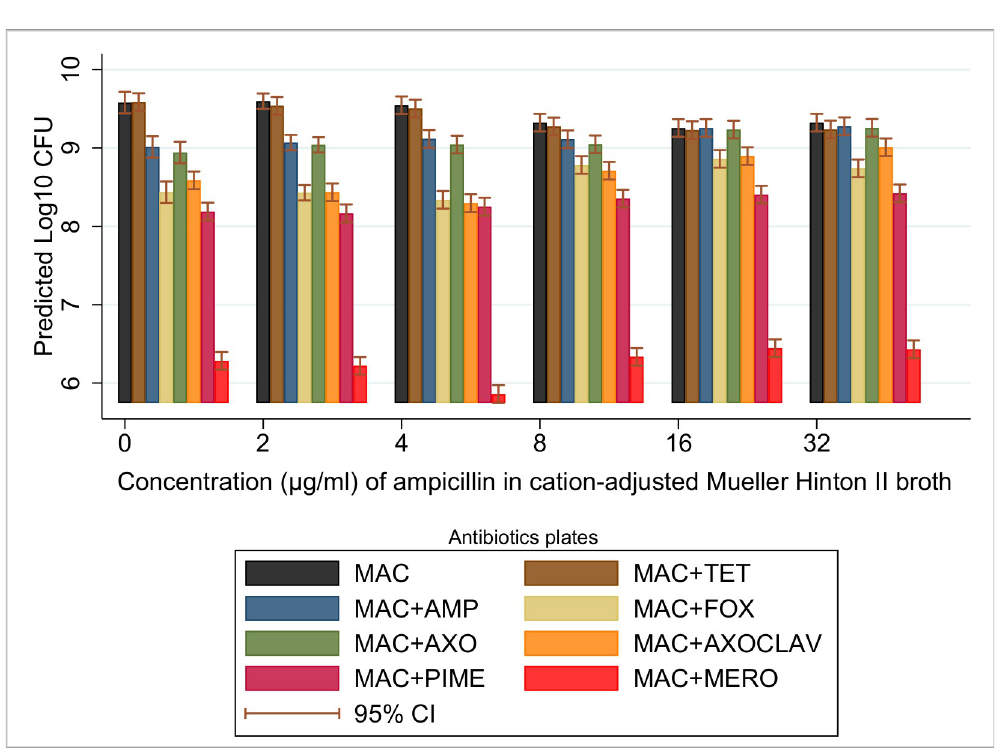
Fig 4. Effects of varying ampicillin concentrations on 10-strain mixed-bacterial culture. Predicted marginal mean counts (log 10 CFU) with 95% CI following 24-hour incubation in ampicillin (at 2, 4, 8, 16, 32 μ g/mL) in cation-adjusted Mueller- Hinton II broth. � The selective MacConkey agar plate antibiotic concentrations were: ampicillin (32 μ g/mL), tetracycline (16 μ g/mL), cefoxitin (32 μ g/mL), ceftriaxone (4 μ g/mL), ceftriaxone (4 μ g/mL) + clavulanic acid (4 μ g/mL), cefepime (8 μ g/ mL), and meropenem (4 μ g/mL); CFU (Colony forming unit).